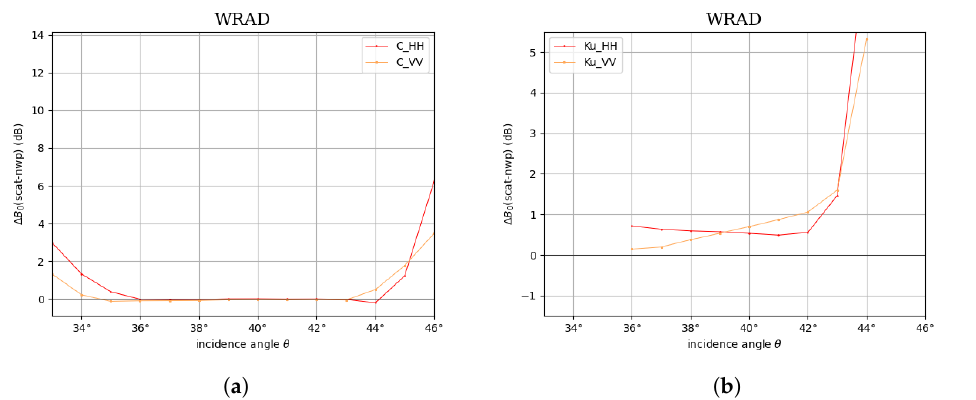
Figure 7. NOC as a function of incidence angle for ascending orbits: ( a ) C-band HH and VV polarization; ( b ) Ku-band HH and VV polarization.